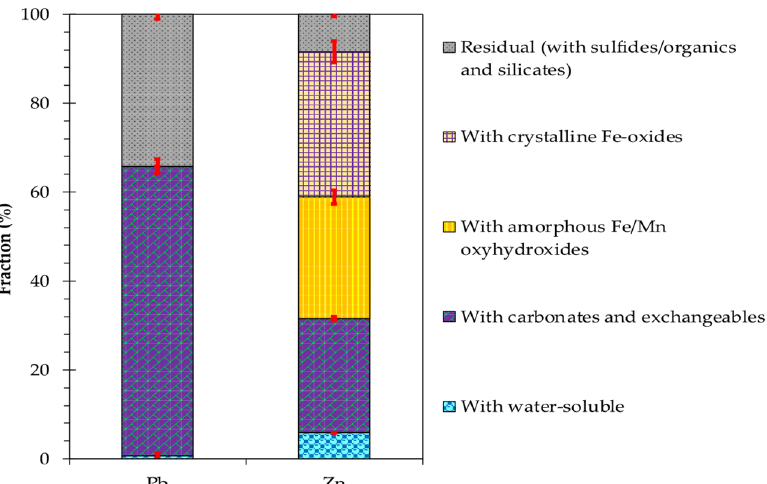
Figure 2. Phase partitioning by sequential extraction of Pb and Zn for ZPLRs (reprinted with permission from Silwamba et al., [31] copyright (2020) Elsevier) (for interpretation of the references to color in this figure legend, the reader is referred to the web version of this article).